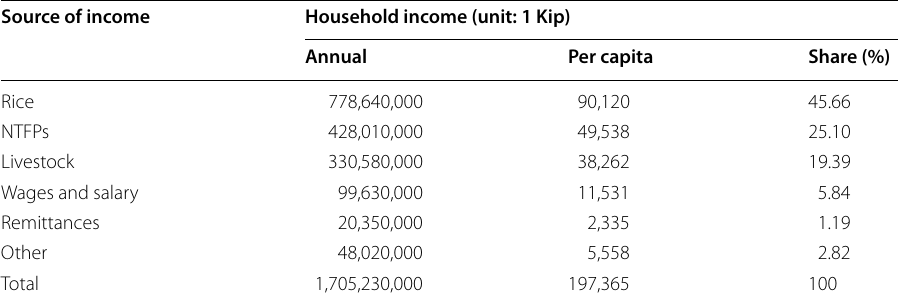
Table 2 Main sources of household income in Phonxay village (2016). Source: Field survey data, March 8,